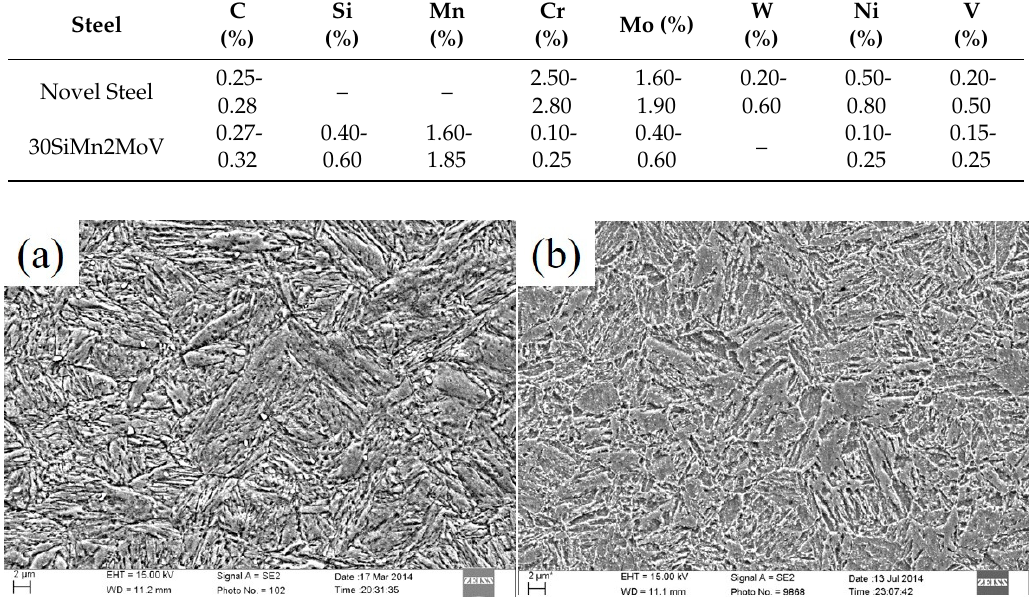
Figure 1. Tempering SEM microstructure of the experiment material: ( a ) novel steel and ( b ) 30SiMn2MoV.